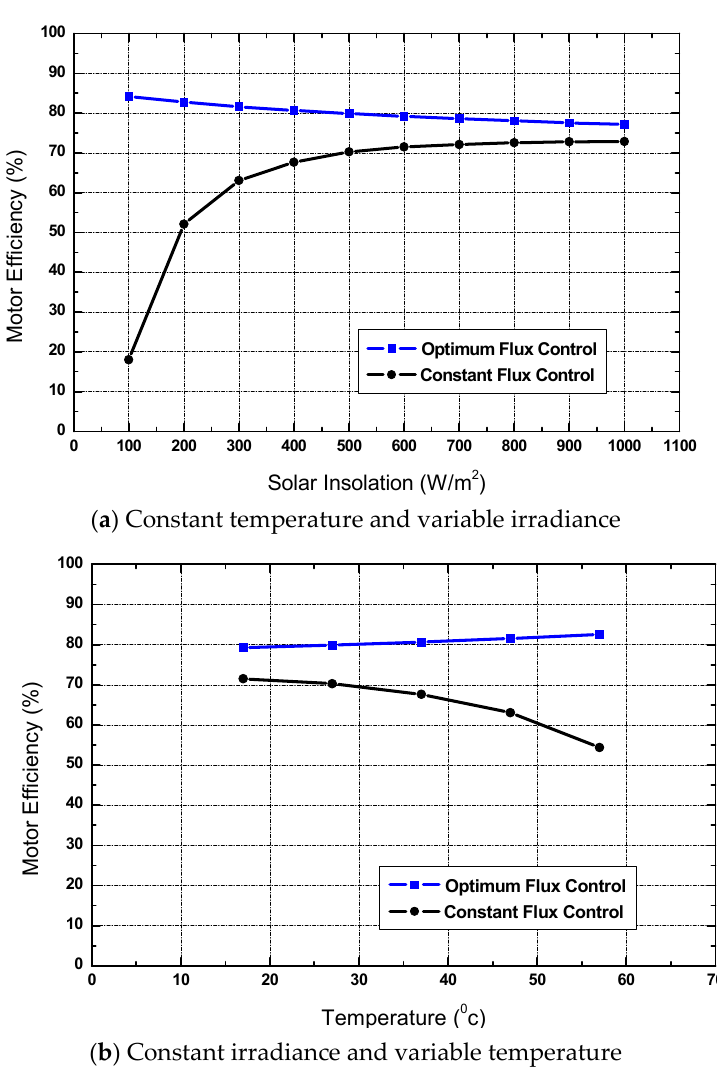
( b ) Constant irradiance and variable temperature Figure 10. Motor efficiency. Figure 10. Motor